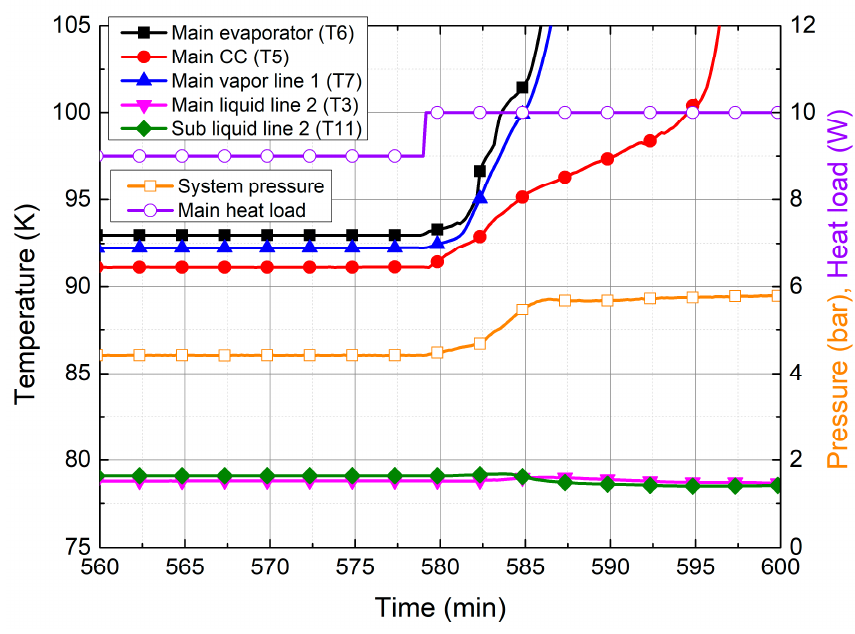
Figure 11. Temperature change in CLHP when dry-out occurred.